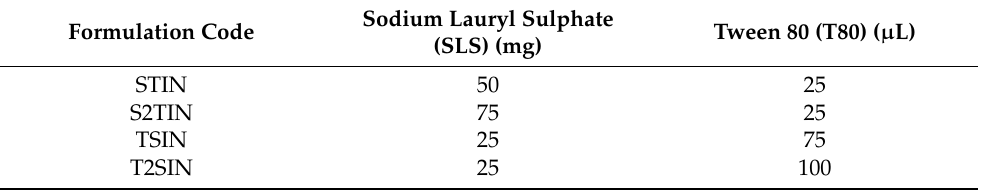
Table 1. Amount of surfactants used in the preparation of NANIMA formulations. Formulation